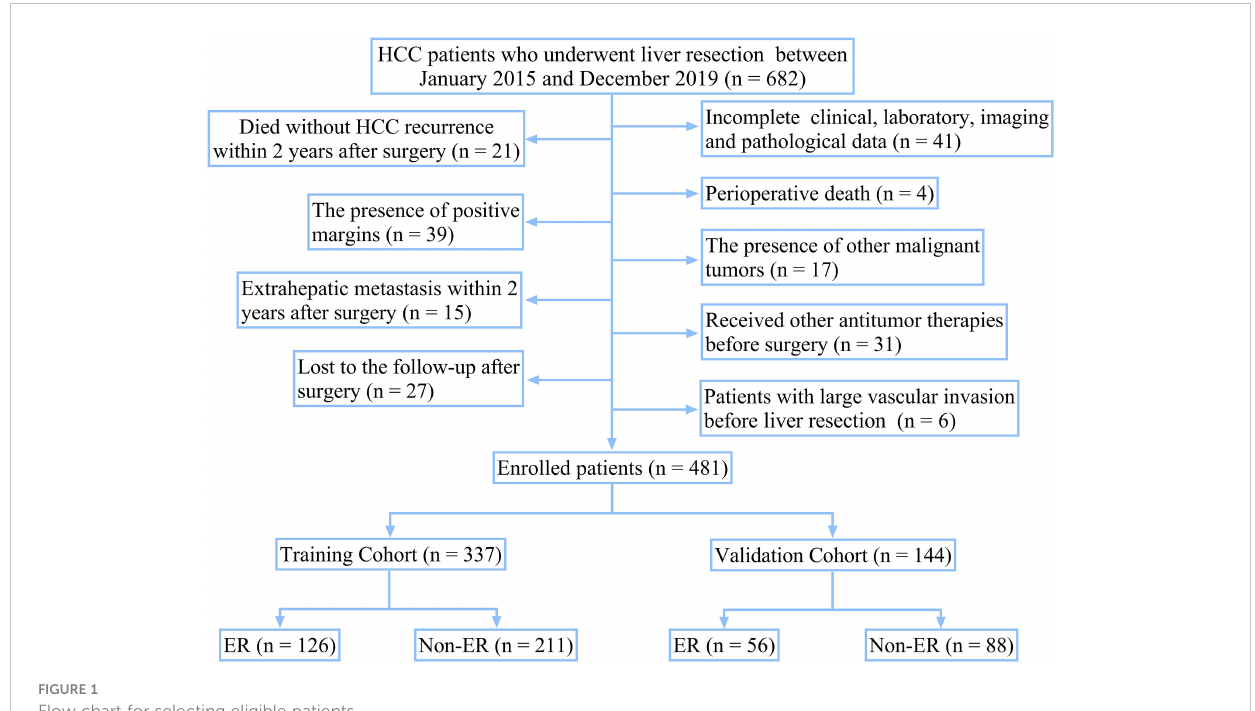
FIGURE 1 Flow chart for selecting eligible